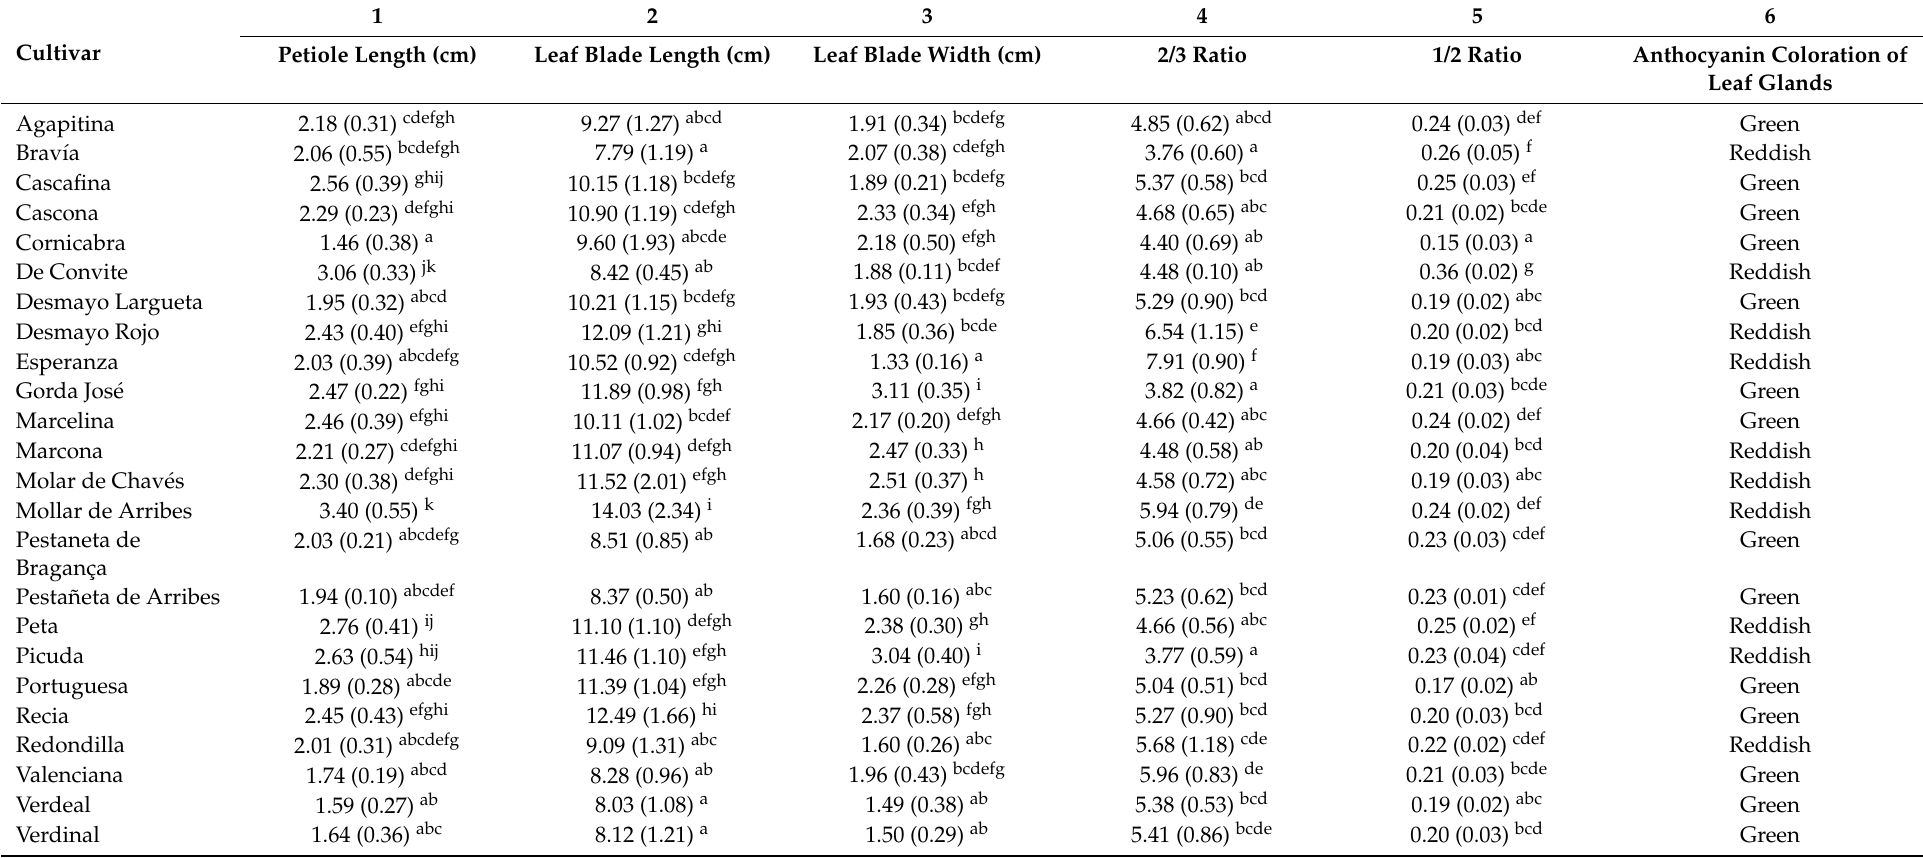
Table 2. Means, standard deviations and ANOVA analyses for some leaf parameters in almond